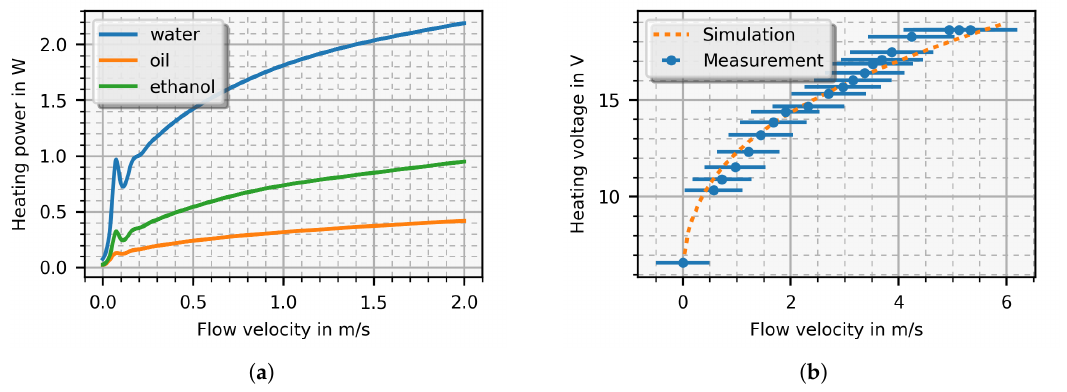
Figure 4. Simulation results as well as a comparison with measurements: ( a ) Simulated heating power of several liquids versus the mean flow velocity, which is need to maintain a 2K temperature difference; ( b ) Measurement of the PCB sensor compared with the simulation for air as fluid. The heater voltage is plotted versus the mean flow velocity where the error bars indicate the error ( ± ( 0.5m/s + 7%fromreading ) ) of the reference